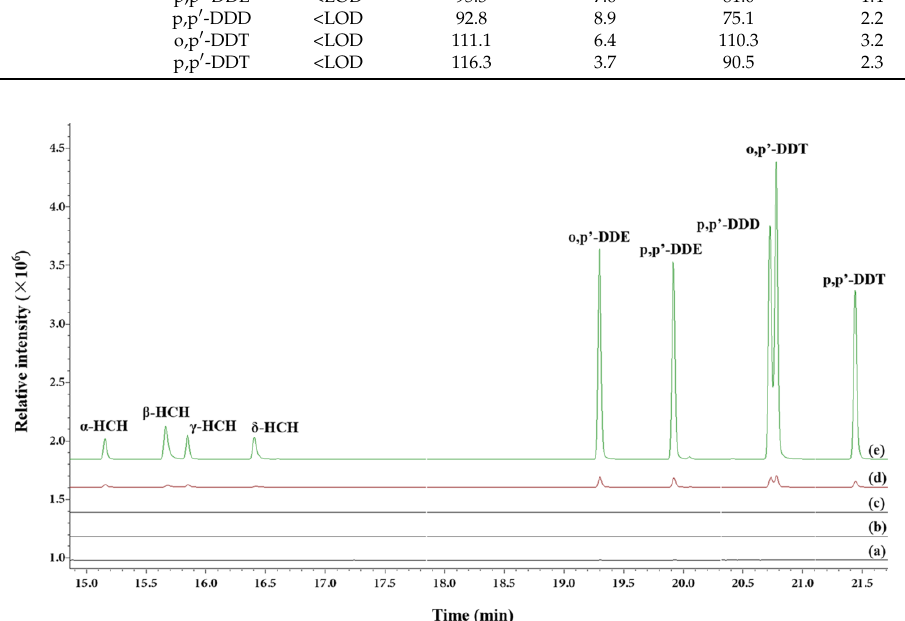
Figure 7. Total ion chromatograms of the nine organochlorine pesticides in water samples obtained by gas chromatography – tandem triple quadrupole mass spectrometry: ( a ) tap water; ( b ) river water; ( c ) underground water; ( d ) tap water spiked at 10 µg L −1 ; and ( e ) tap water spiked at 100 µg L −1 . Table 4. Analytical results for determination of organochlorine pesticides in real water samples.